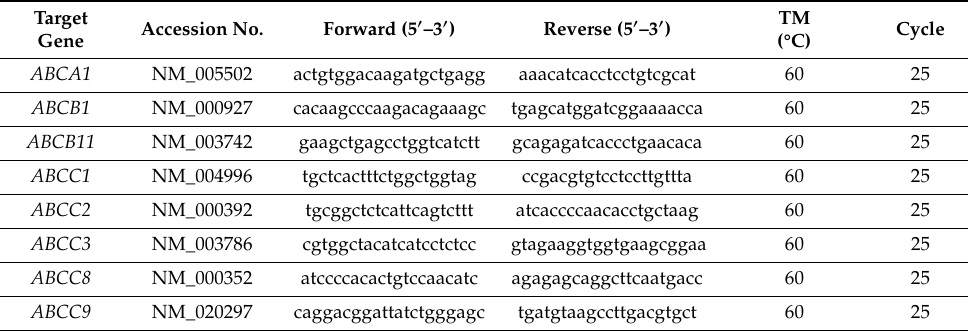
Table 2. The primers for glyburide-sensitive human ABC